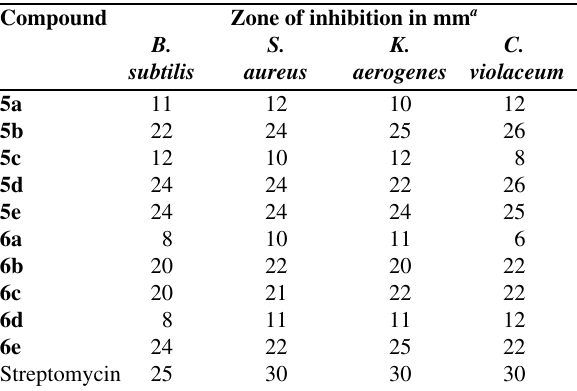
Table 1. Antibacterial activity of 5a – e and 6a – e